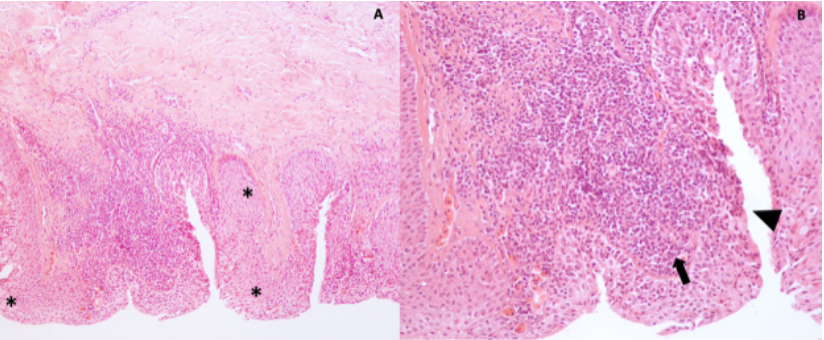
Figure 7. ( A , B ) Tissue from the left eye. A dense fibrovascular tissue covered by an epithelium diffusely hyperplastic (hyperplasia, asterisks) and multifocally lost (erosion, arrowhead). The subepithelial connective tissue is focally infiltrated by mononuclear inflammatory cells (arrow). Hematoxylin and eosin stain, 10× and 20×.